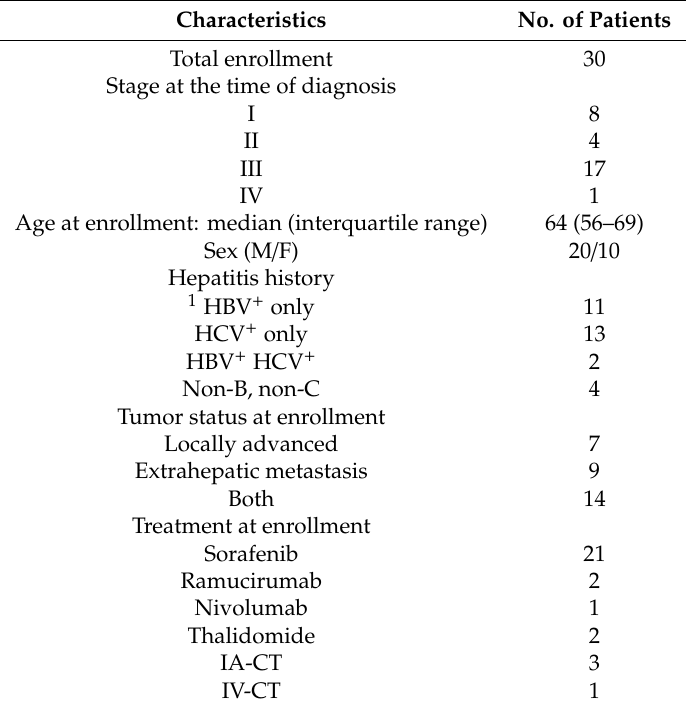
Table 1. Basic characteristics of patients enrolled in this